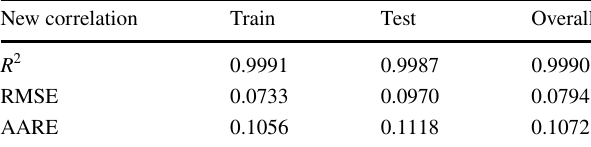
Table 9 Statistical error of HFP based on new correlation